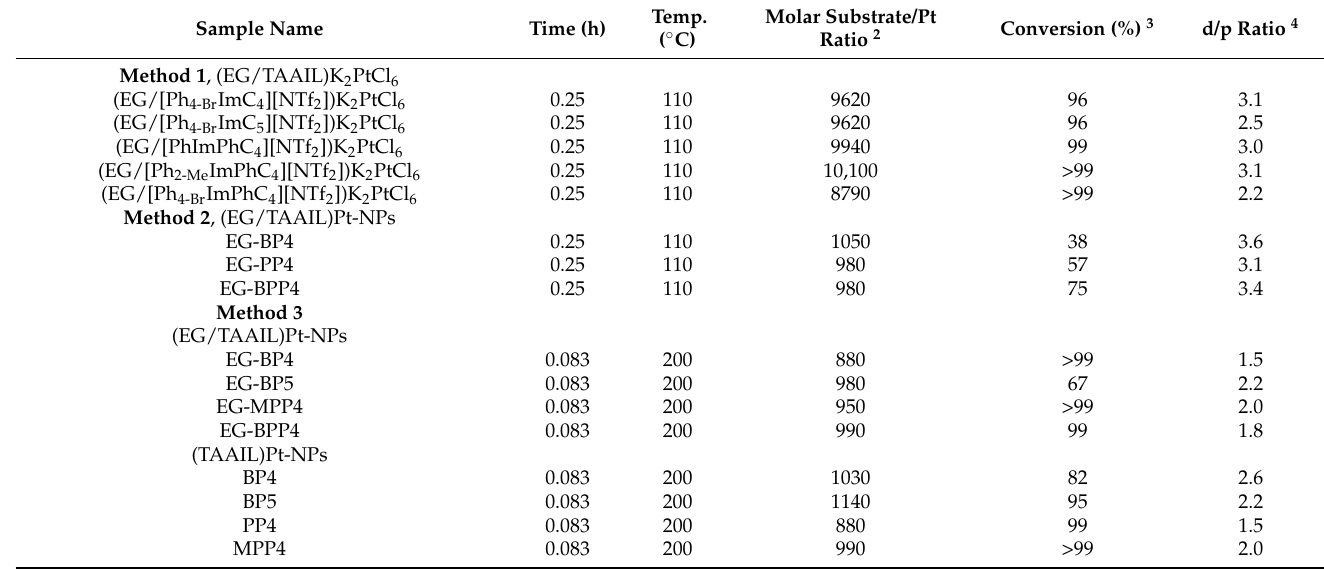
Table 5. Catalytic hydrosilylation of phenylacetylene with triethylsilane 1